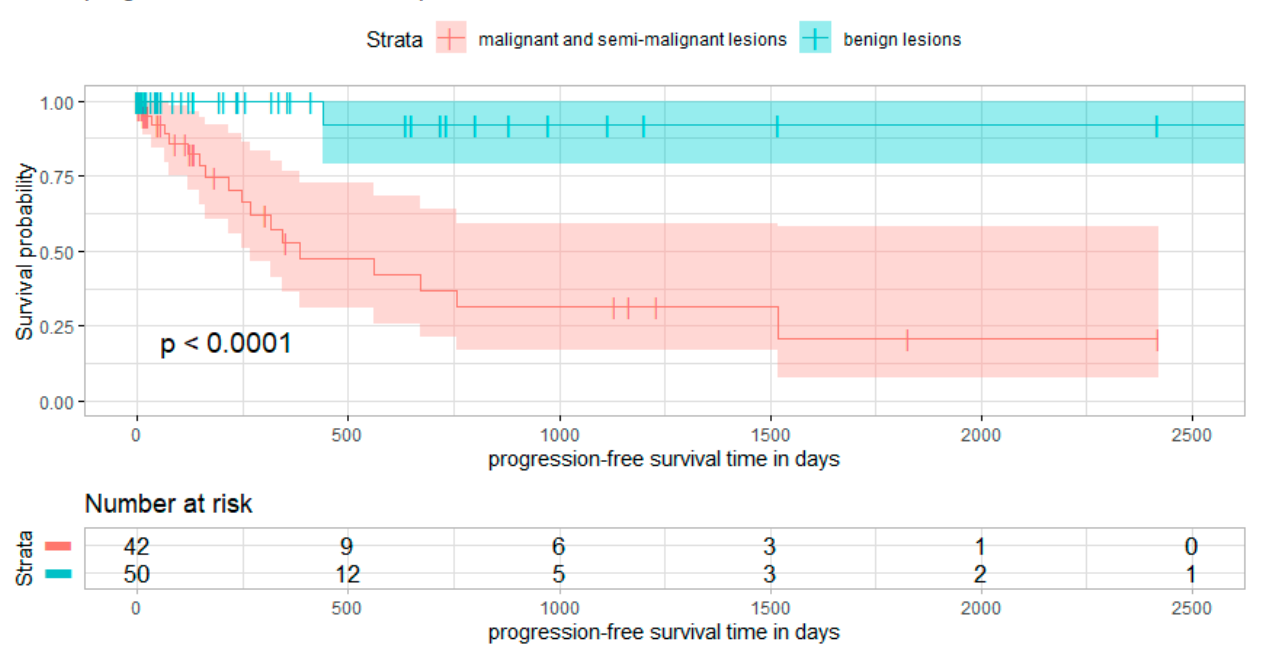
Figure 4. Progression-free survival. Survival curves for progression-free survival, subdivided into the subgroups of benign lesions (blue) and malignant/semi-malignant lesions (red). Curve comparison shows significant differences between curves. Log rank test of benign vs. malignant/semi-malignant lesions: X 2 = 18, p < 0.0001.